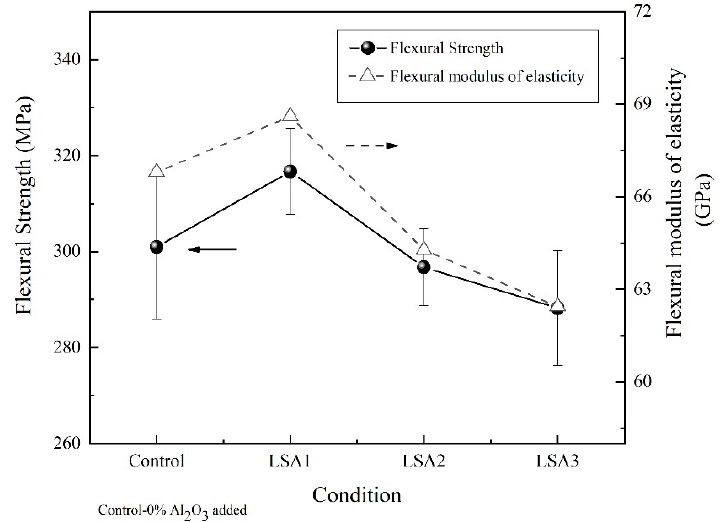
Figure 4. Flexural strength and flexural modulus of elasticity of the glass–ceramic samples with different Al 2 O 3 contents after heat treatment at 600/800 °C. Table 1. Mechanical properties of dental